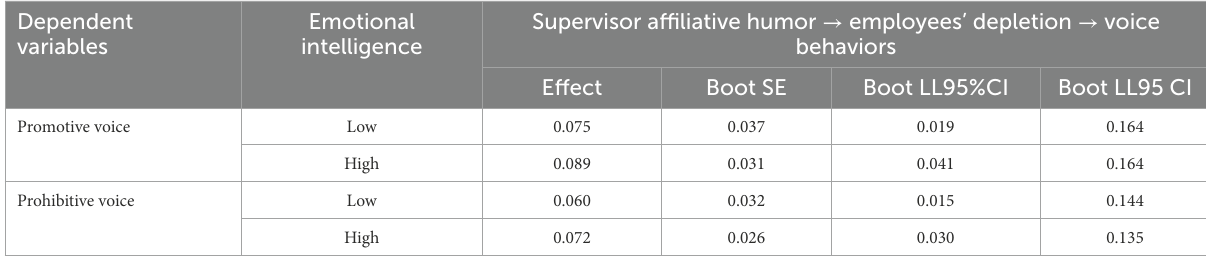
TABLE 7 Results of the moderated path analysis